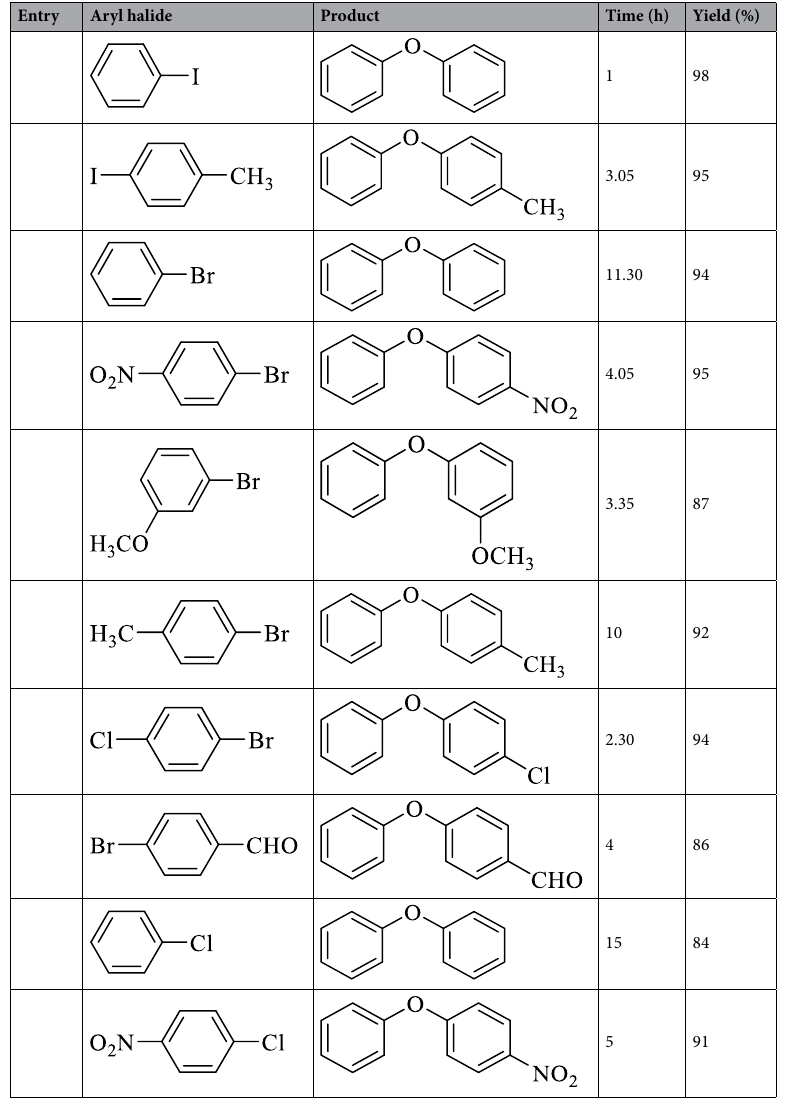
Table 6. Synthesis of diaryl ether derivatives using Cu(II)-MP-bis(AMP)@boehmite. Isolated yield.